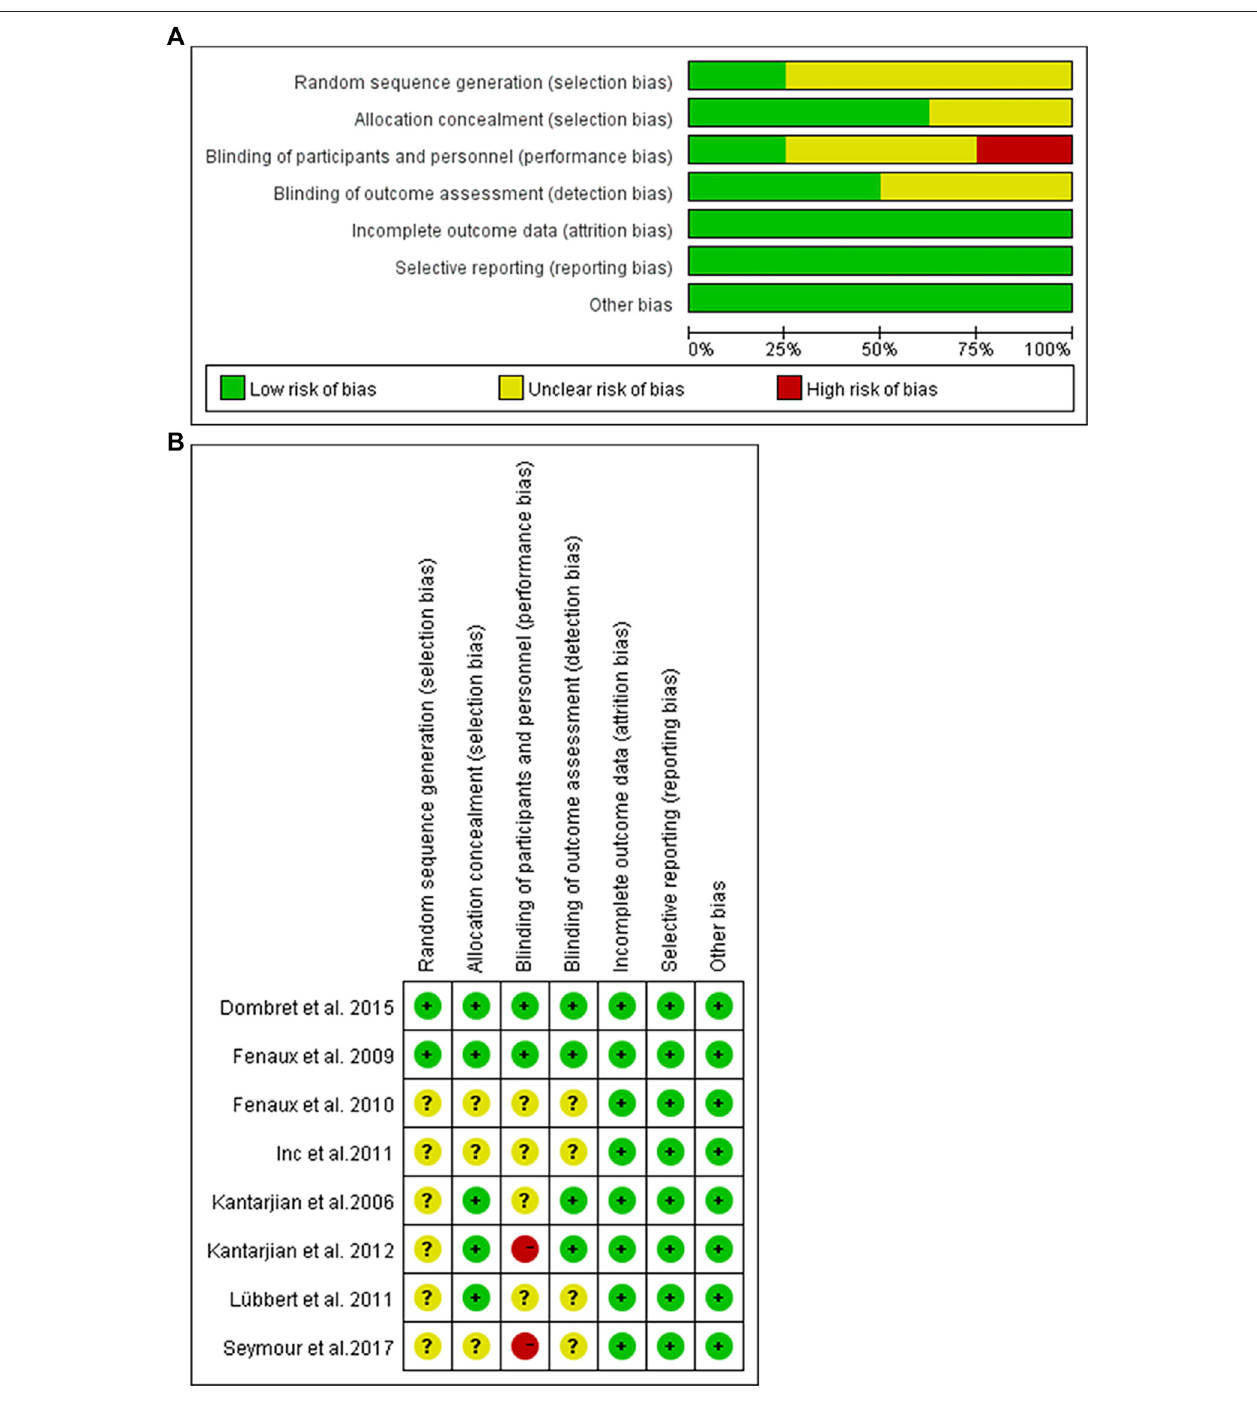
FIGURE3| Riskofbiasgraph. (A) Authors ’ judgmentsabouteachriskofbiasitempresentedaspercentagesacrossallincludedstudies. (B) Riskofbiassummary. Authors ’ judgments about each risk of bias item for each included study.